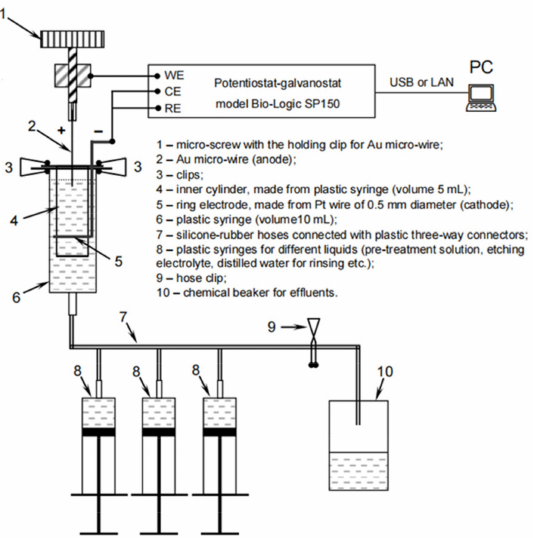
Figure 1. The principal set-up scheme for the preparation of all-metal Au probes by electrochemical etching of an Au micro-wire in the flow-through electrochemical